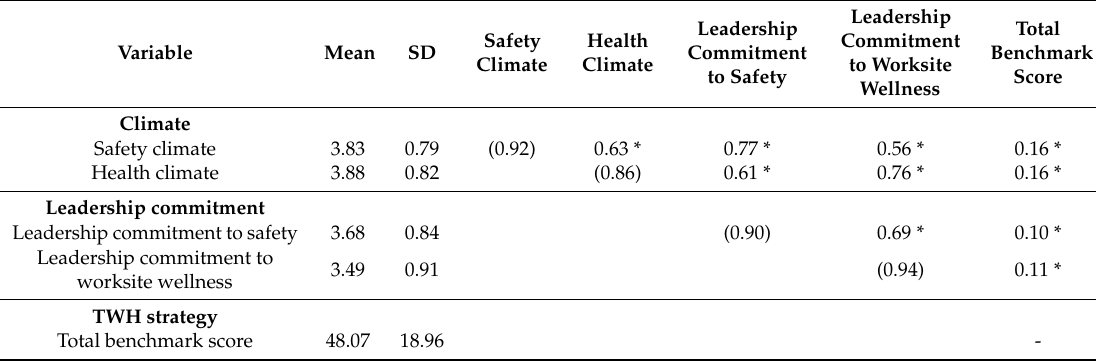
Table 3. Means, standard deviations, reliabilities, and correlations of TWH strategy, safety and health climates, and health and safety leadership